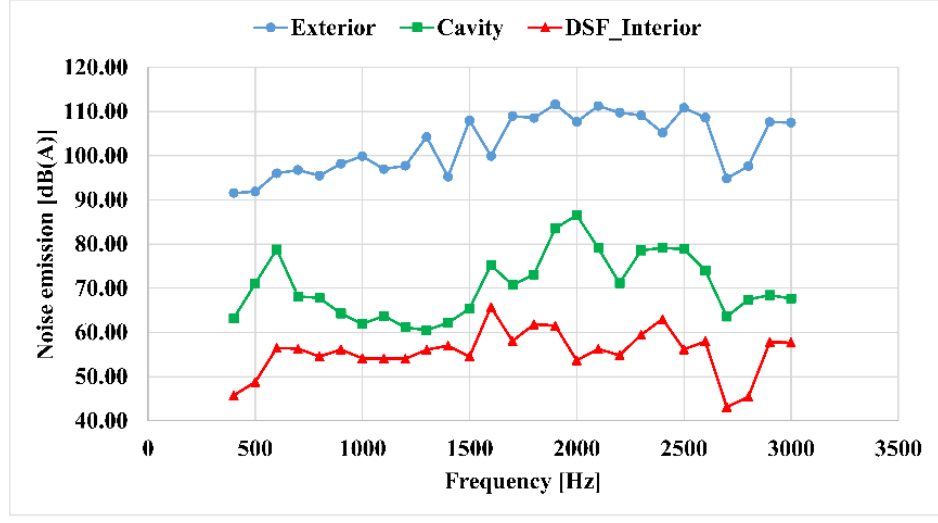
Figure 4. Noise level measured in different locations of the box double-skin façade, frequency interval 400–3000 Hz.